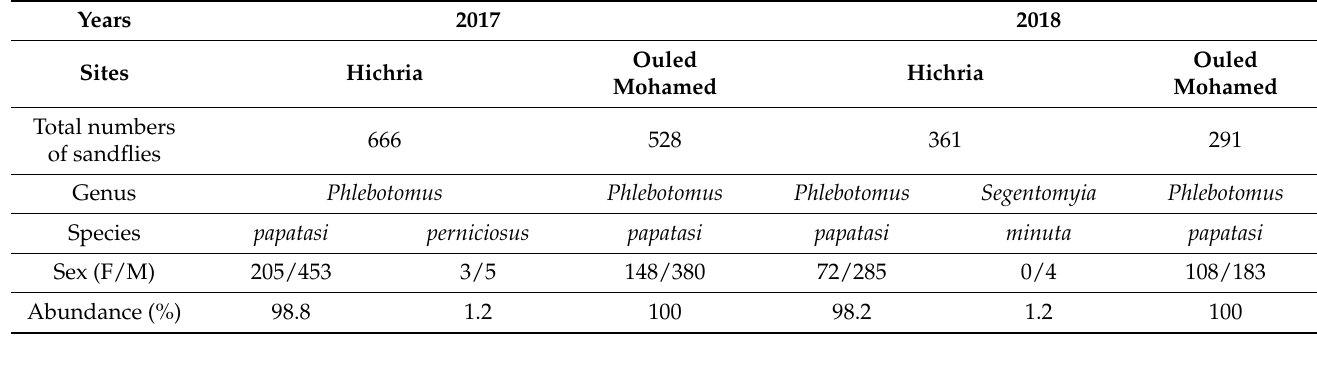
Table 1. Sandfly fauna collected in Hichria and in Ouled Mohamed in 2017 and 2018.